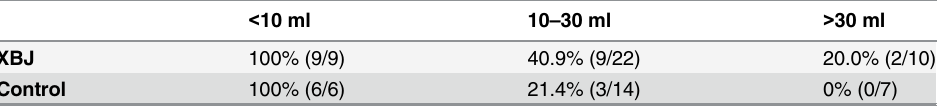
Table 2. 28-day survival rates of patients ingesting different volumes of 20% liquid paraquat (w/v). < 10